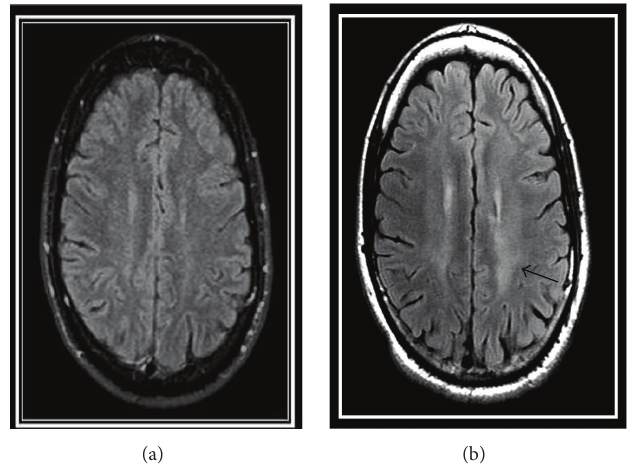
Figure 3: MRI-FLAIR protocol. Left: initial MRI, 04/12. Right: MRI following relapse 10/12. Note a diffuse hyperintense, ill-defined, left hemispheric centrum semiovale lesion superior to the lateral ventricles (black